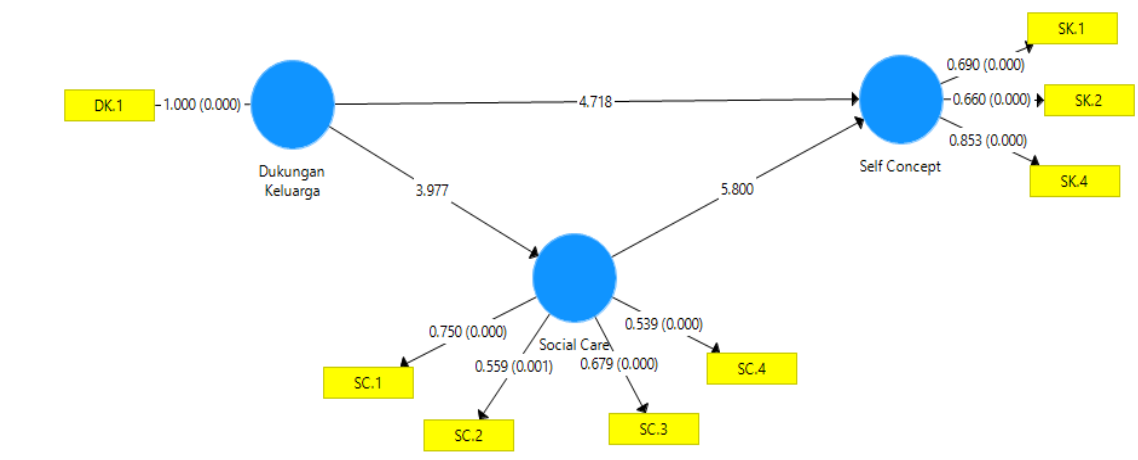
Figure 1. Self-concept model of leprosy patients based on path analysis before reconstruction